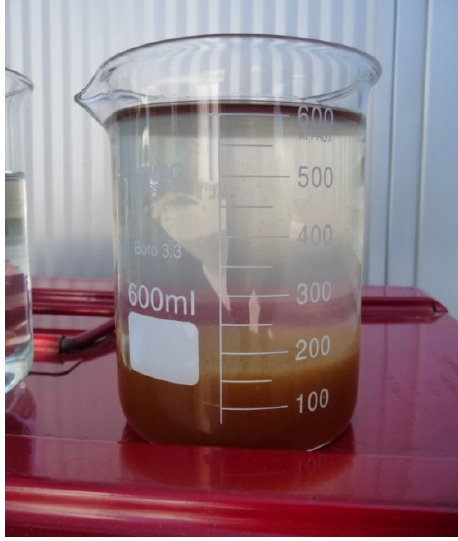
Figure 4. Reject water after 30 min sedimentation.